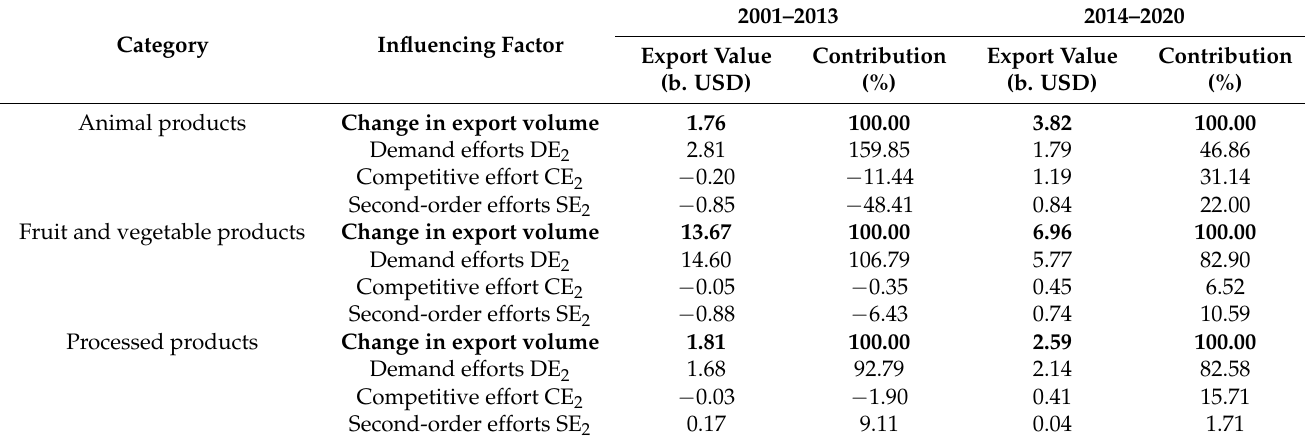
Table 6. Empirical results of the distribution of B&R countries export agricultural to